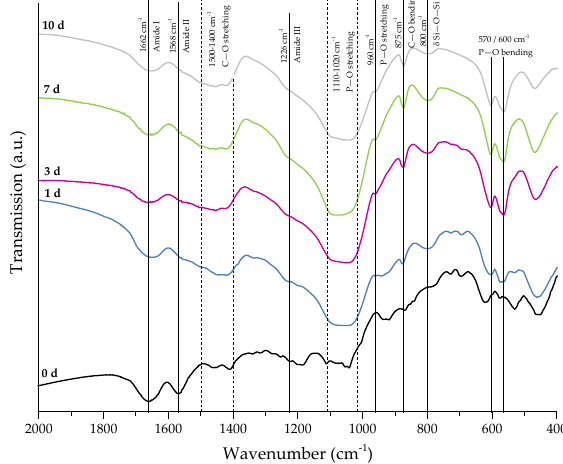
Figure 9. FTIR spectra of collagen-coated 45S5 BG-based scaffolds (crosslinked) after 0, 1, 3, 7, and 10 days of immersion in SBF. Relevant peaks are discussed in the text.